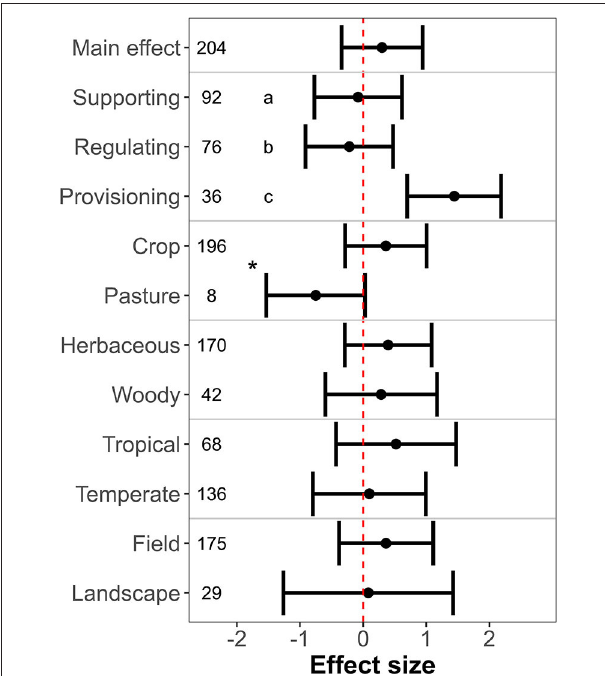
FIGURE 5 | Ecosystem services levels in farmland with hedgerows as compared to natural habitat. X-axis indicates the mean effect size (standardized mean difference) ± 95% confidence interval. The dashed vertical red line shows the null effect. A confidence interval that overlaps this line means that the effects are not